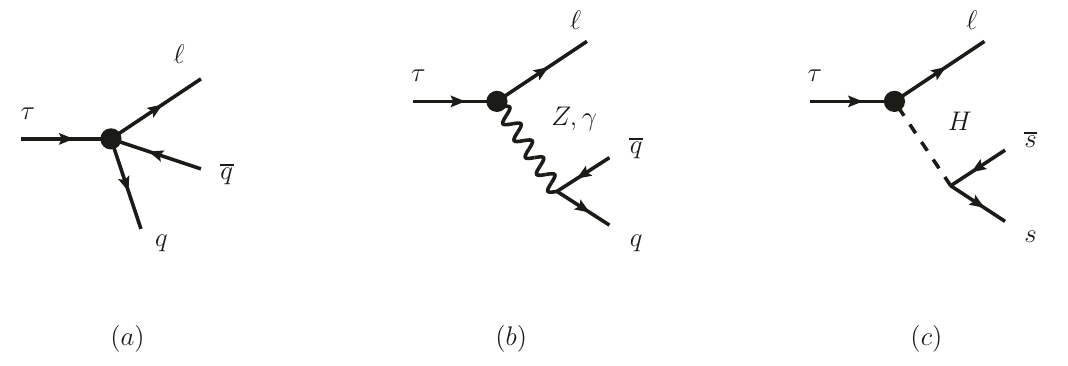
Figure 1 . Different contributions of the SMEFT Lagrangian to τ → ‘ qq , with ‘ = e, µ . The dot indicates the CLFV vertex. We consider m u = m d = 0 , but m s 6 = 0 : the contribution of the Higgs in (c) thus only exists for the production of ss